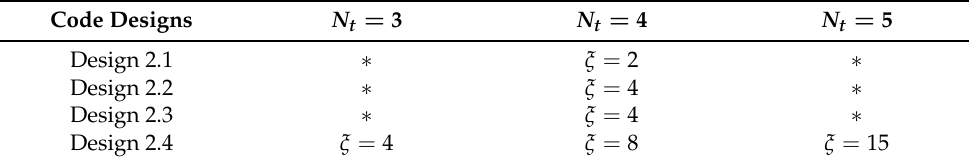
Table 1. Decoding